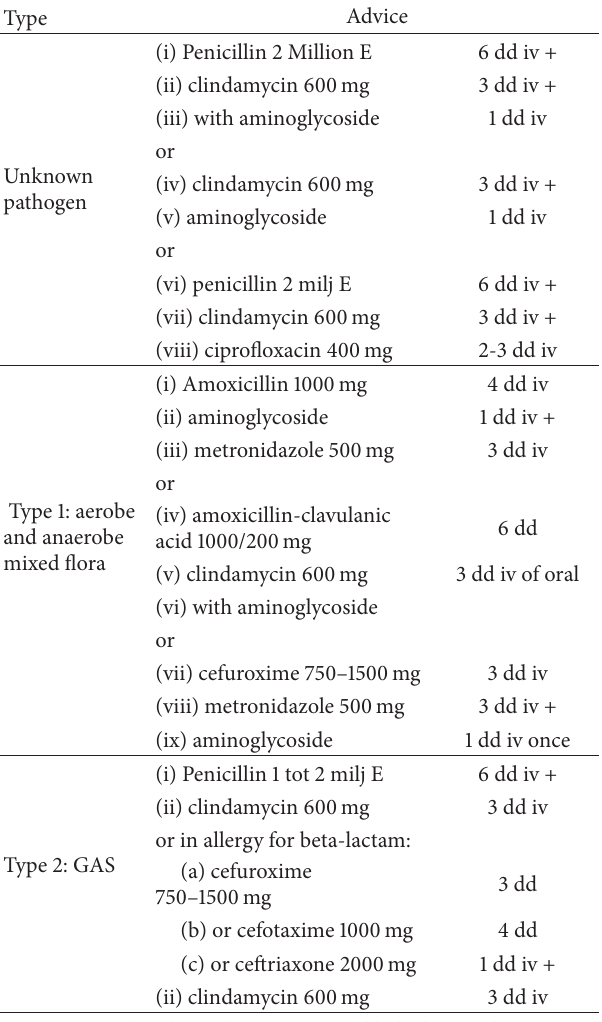
Table 1: Foundation working party on antibiotic policy necrotizing